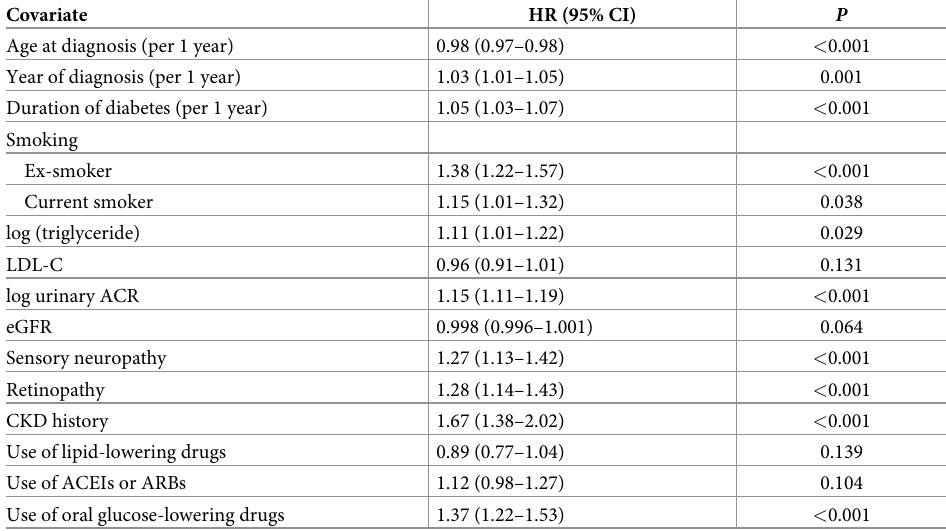
Table 2. Multivariate Cox proportional hazards model derived from stepwise model selection by the Akaike infor- mation criterion for diabetes progression.